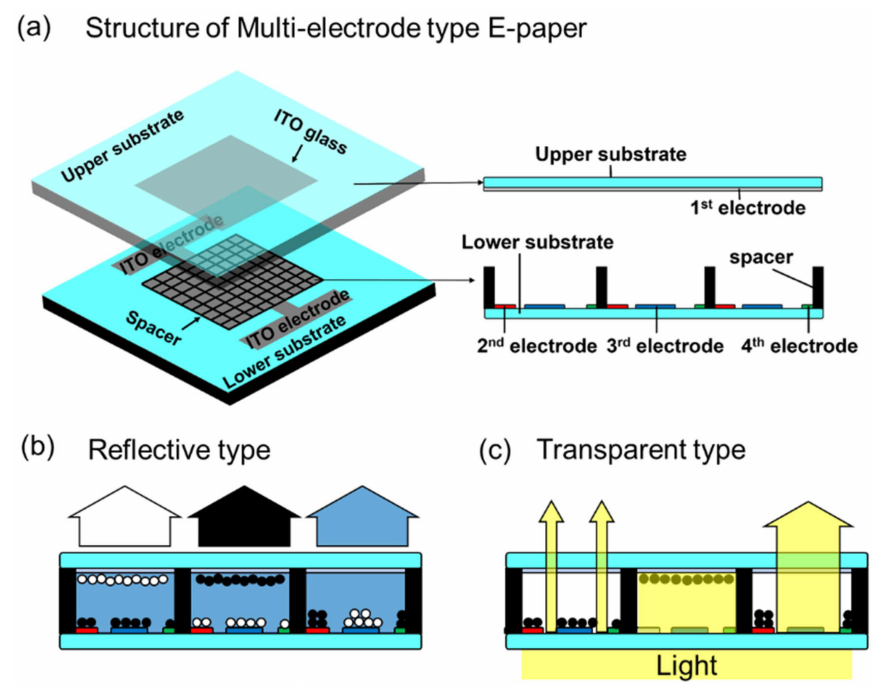
Figure 5. ( a ) Structure and driving method of multi-electrode type electronic paper and its schematic illustration for mechanism of ( b ) reflective type and ( c ) transparent